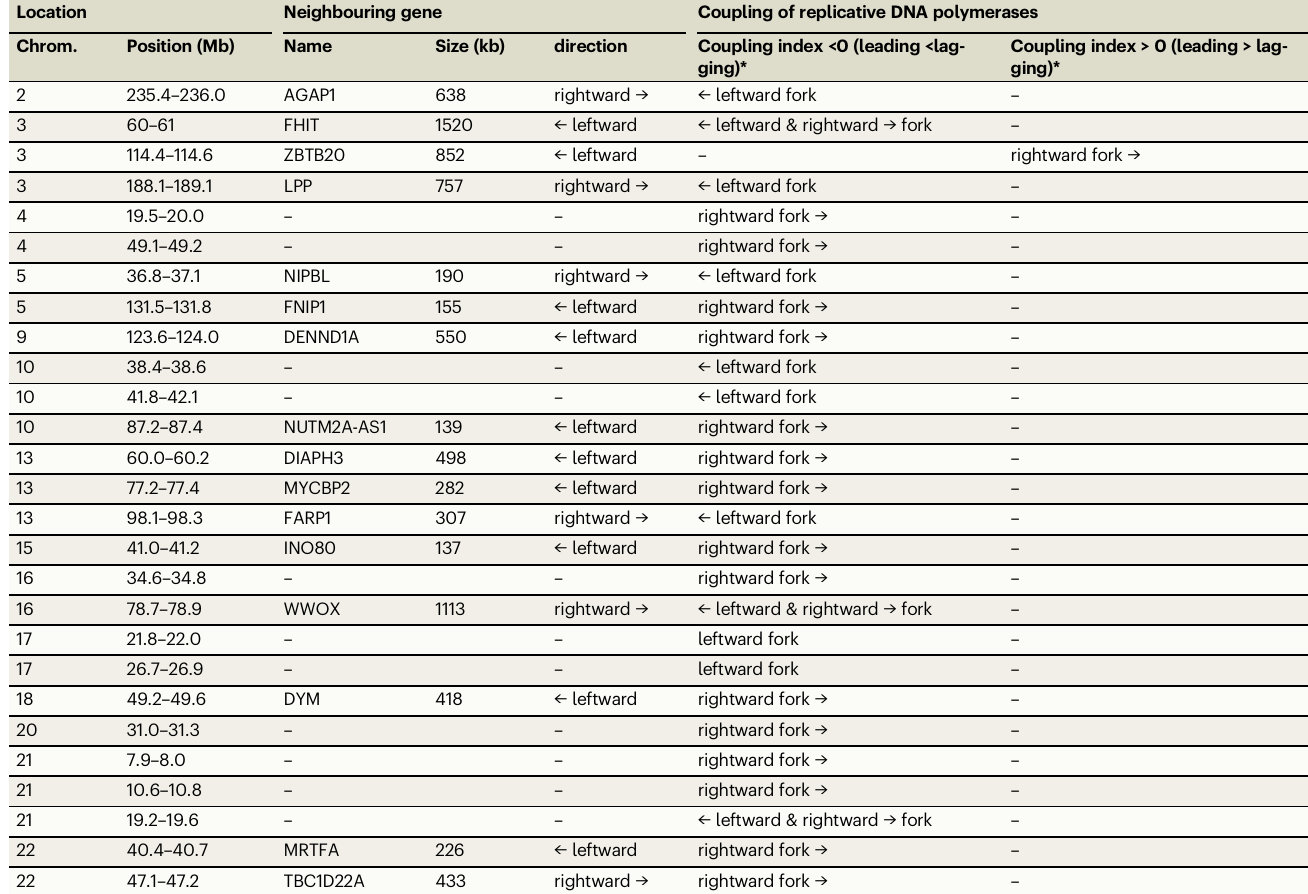
Table 1 | Coupling index outliner